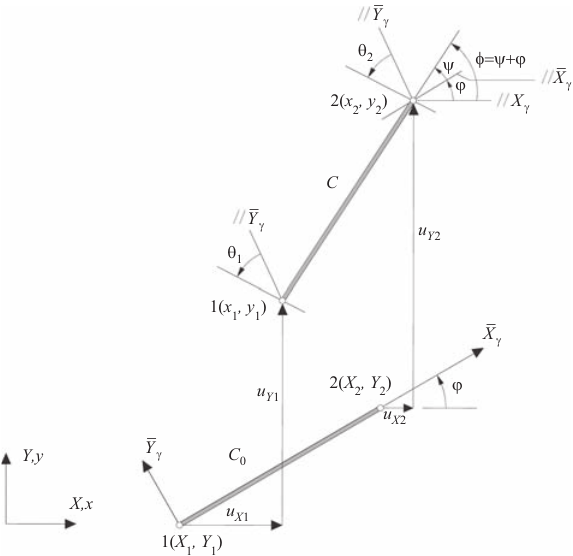
Figure 5 Plane beam element with arbitrarily oriented reference confi guration [41]